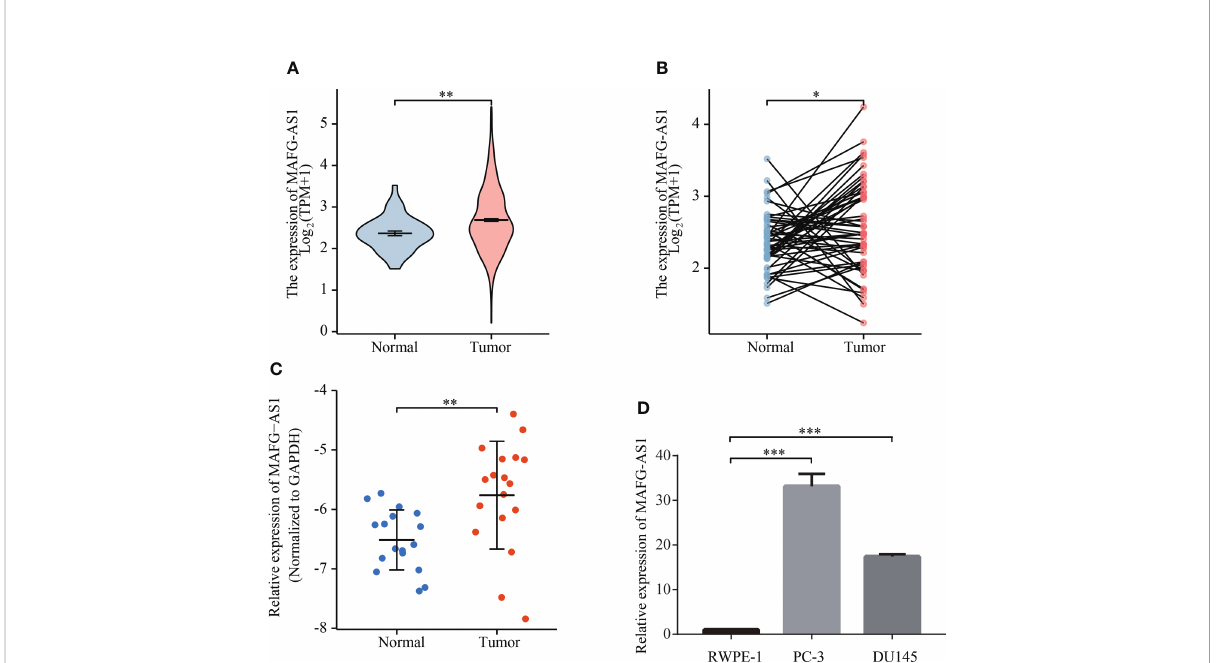
FIGURE 1 MAFG-AS1 was highly expressed in prostate cancer. (A) MAFG-AS1 expression in prostate cancer and adjacent normal tissue in TCGA database. (B) MAFG-AS1 expression in 50 pairs of prostate cancer and adjacent normal tissue in TCGA database. (C) MAFG-AS1 expression in prostate